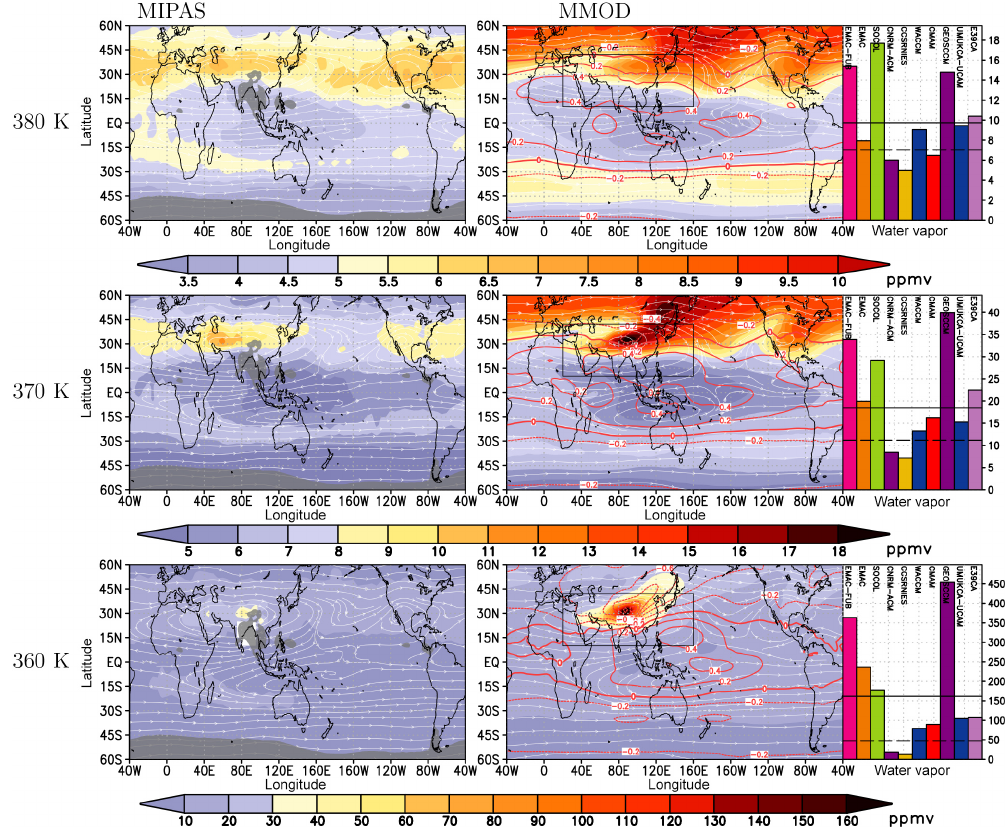
Figure 3. Long-term monthly-mean H 2 O mixing ratios in ppmv for JA at 360, 370, and 380K (from bottom to top) for latitudes from 60 ◦ S to 60 ◦ N; left: MIPAS (2003, 2005–2011), overlaid grey shaded regions where the OLR ≤ 205Wm − 2 ; right: the multi-model average (45 years). Overlaid as streamlines are the horizontal wind components; red contours indicate the net radiative heating rates in Kday − 1 . The maximum of individual models within the area marked by the black rectangle is displayed as bar chart, where the solid horizontal line represents the MMOD and the dashed horizontal line represents the maximum of